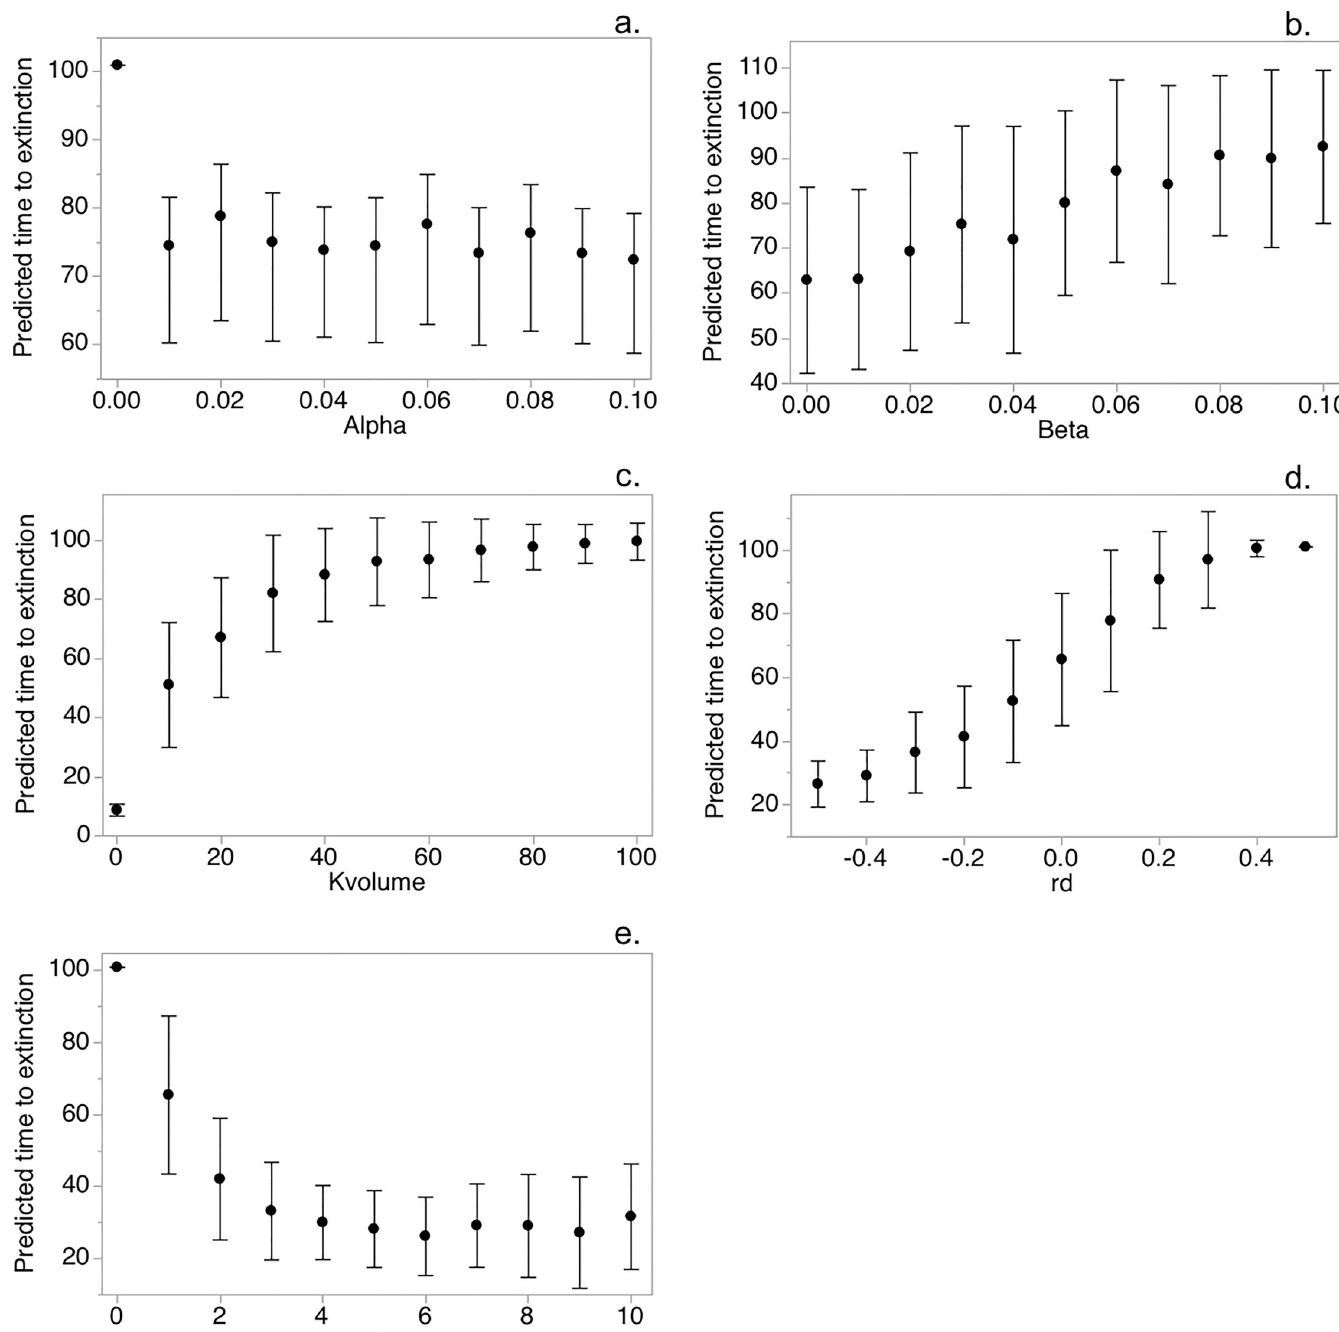
Fig 2. Sensitivity analysis plots. Sensitivity of predicted times before Amargosa voles are extinct (T e ) on a spectrum of values for five parameters in a simulation model metavole . R . Parameters including (A) mean dispersal distance, α , (B) migration calibrator, β , (C) patch carrying capacity, K volume , (D) estimated rate of population , and (E) environmental stochasticity, v , are described in the text. Graph gives mean Te and standard deviation. growth, r d r